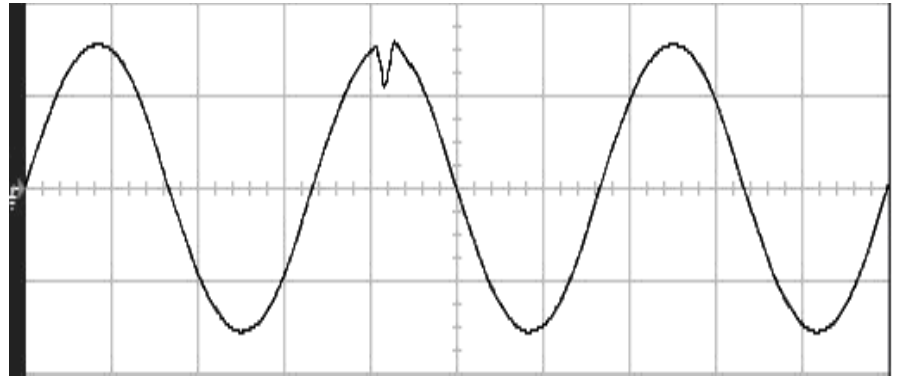
Figure 12. Experimental output voltage with conventional RSMC under step changing in resistive Micromachines 2022 , 13 , x